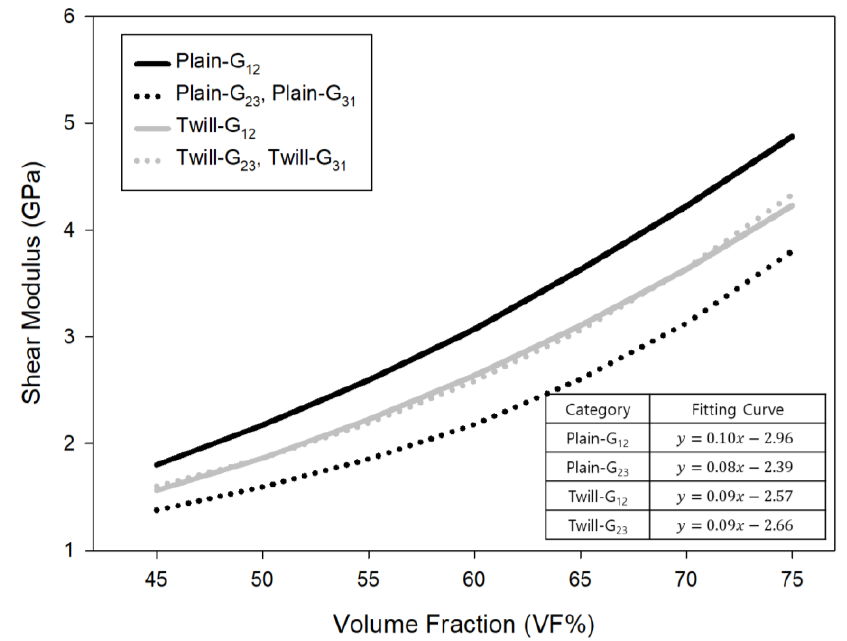
Figure 4. Comparison of the predicted values of shear modulus.